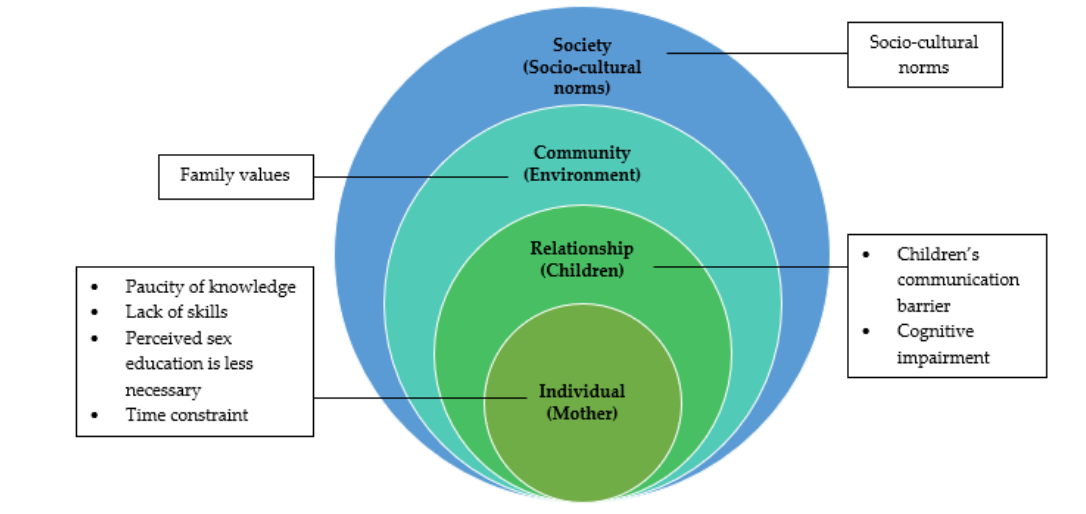
Figure 1. Adapted theoretical framework from McLeroy, Bibeau, Steckler, and Glanz Social-Ecolog- ical Model.